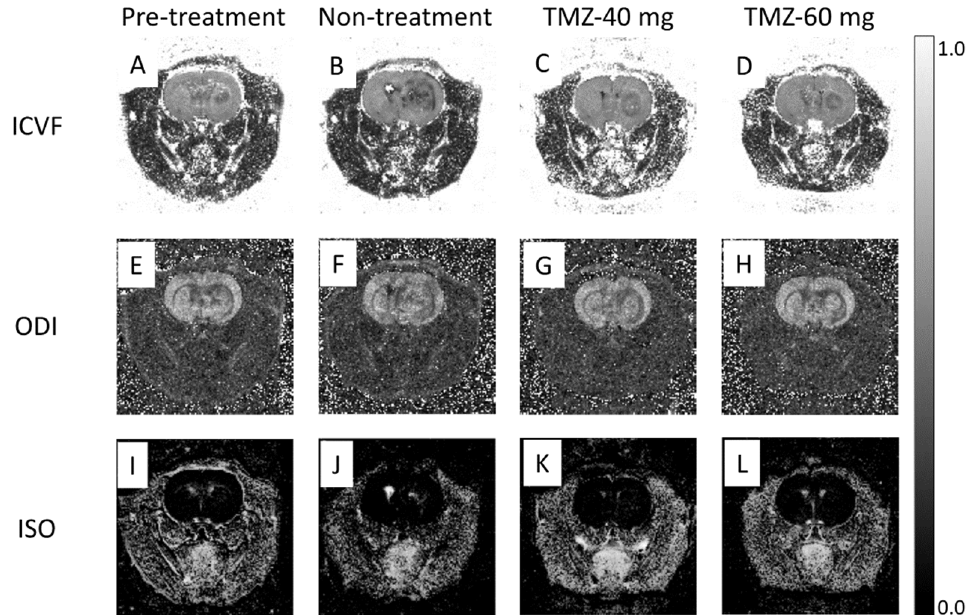
Figure 6. Representative ICVF maps, ODI maps, and ISO maps of pre-treatment group ( A , E , I ) on day 7 after transplantation and non-treatment group ( B , F , J ), TMZ-40 mg ( C , G , K ), and TMZ-60 mg ( D , H , L ) on day 14 after transplantation. TMZ, temozolomide; ICVF, intracellular volume fraction; ODI, orientation dispersion index; ISO, isotropic volume fraction.